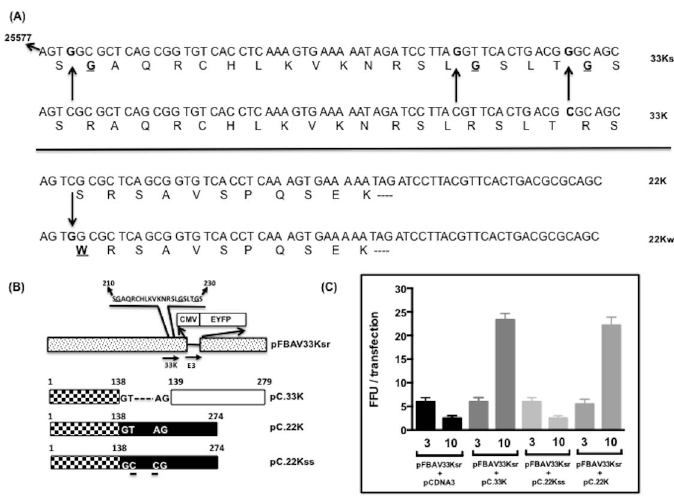
Figure 6. L6 33K and 22K. ( A ) Sequence of 33K and 22K . The nucleotide numbers of BAdV-3 genome shown are according to Gene bank accession # AF030154. The changed nucleotide residues in 33K and 22K are shown in bold. The substituted amino acid in 33Ksr or 22Kw is shown in bold and underlines. ( B ). Schematic representation of plasmid pFBAV33Ksr . BAdV-3 genome (dotted pattern box). The thin line represented deleted E3 region [45]. The substituted amino acids (glycines) of 33K in BAdV-3 genome are underlined. The numbers represent the amino acid numbers of 33K. CMV (human cytomegalovirus immediate early promoter); EYFP (enhanced yellow fluorescent protein). Arrows represent the direction of transcription. The coding sequences shared by 33K and 22K (box with pattern) or specific for 33K (hollow box) and 22K (black box) are depicted. The spliced region in 33K is represented by dots flanked by splice donor\acceptor sites. The wild-type (GT…AG) and mutated (GC…CG) splice acceptor/donor sites are depicted. The numbers of the top denote amino acid numbers. ( C ) Complementation of pFBAV33Ksr genome . The VIDO DT1 cells were co transfected with indicated plasmids and the fluorescent focus forming units were counted at indicated days post transfection. The numbers on the X- axis denote the days post transfection.